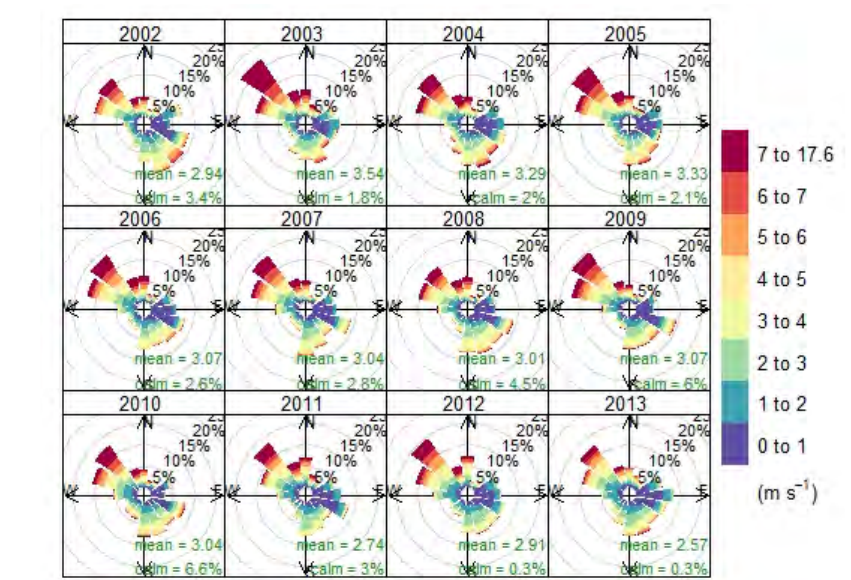
Fig. 2: Annual wind roses for the period 2002-2013 registered at San Vito station.